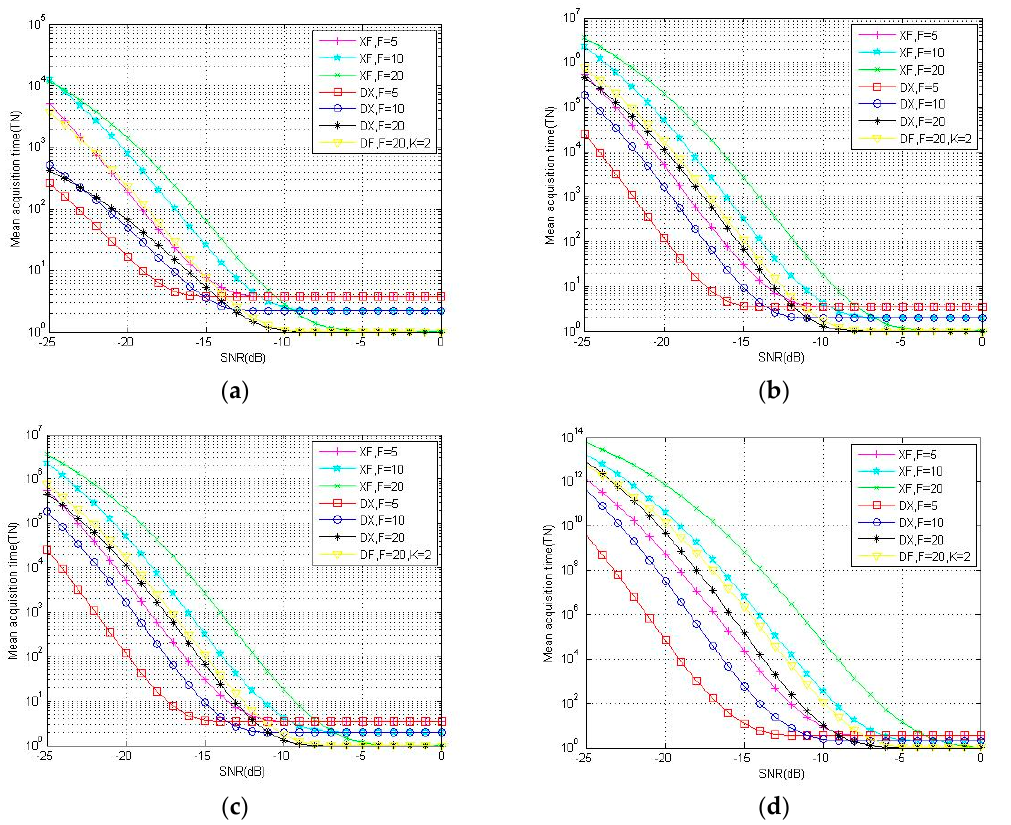
Figure 6. Theoretical results for mean acquisition time under 1–4 verification times (N th ) of DC- XFAST (“DX”).